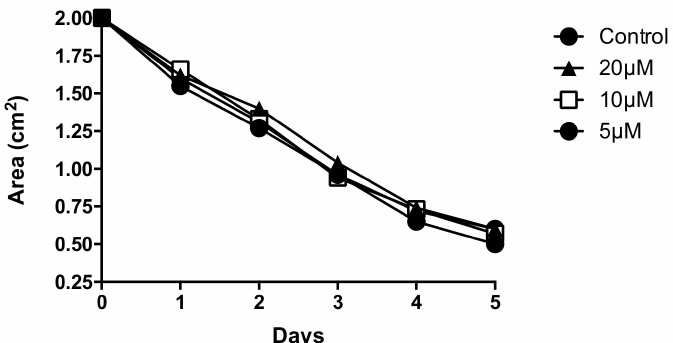
Figure 2. A β 1-40 peptides did not alter HBVSMC contractility. At 5, 10 or 20 µ M. A β 1-40 did not